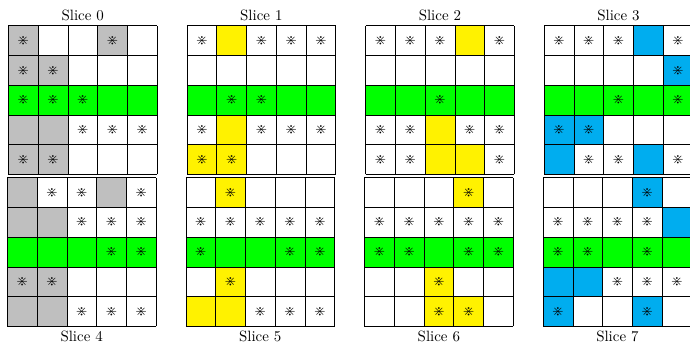
Figure 9: C 1 : the green part is known, the bits with (cid:62) correspond to the half state A u , the other ones to A v . Bits colored in yellow, grey or blue correspond to the best choice of guesses such that an entire slice is known after χ